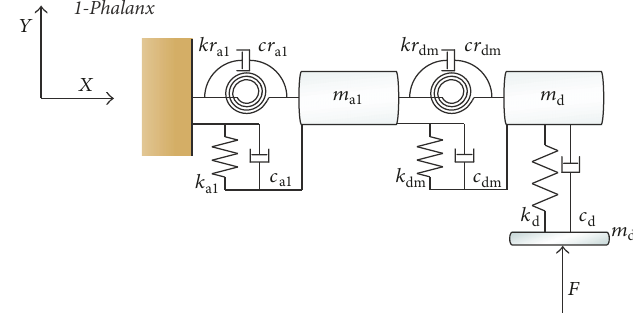
Figure 2: The model configuration used for the distal finger phalanx (denoted as 1-Phalanx).